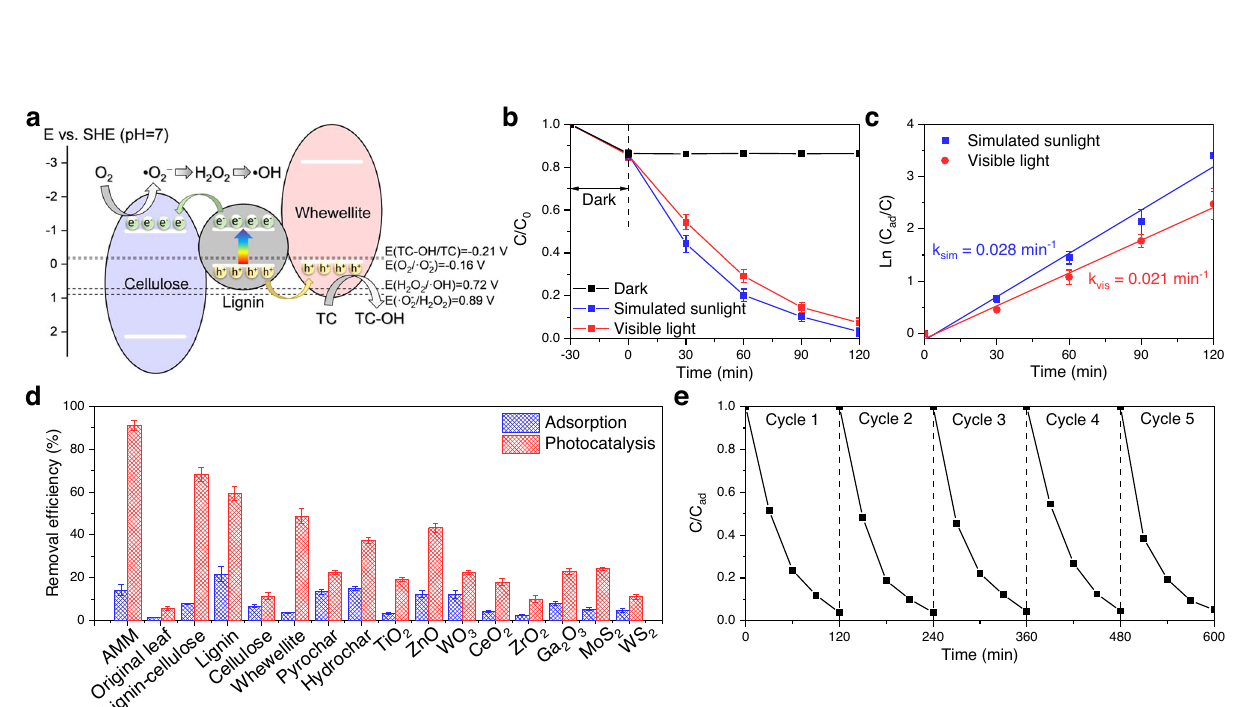
photocatalytic hydrogen production over it. c Time-resolved fl uorescence decay curves. d Transient photocurrent response under visible light (alternating light-on for 30s and light-off for 30s). e Photocatalytic hydrogen production from a methanol-watermixtureovertheAMM fi